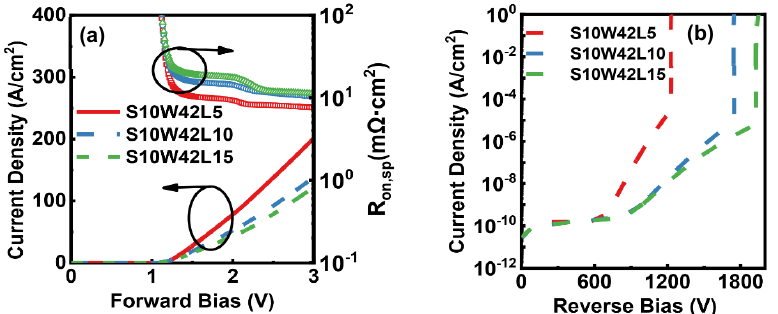
Figure 8. ( a ) Forward J ‐ V and ( b ) reverse J ‐ V characteristics of the Ga 2 O 3 SBD with 5 μ m, 10 μ m, and 15 μ m drift layer thicknesses, when the width of GR is 42 μ m and the doping concentration of GR is 1 × 10 18 cm − 3 .